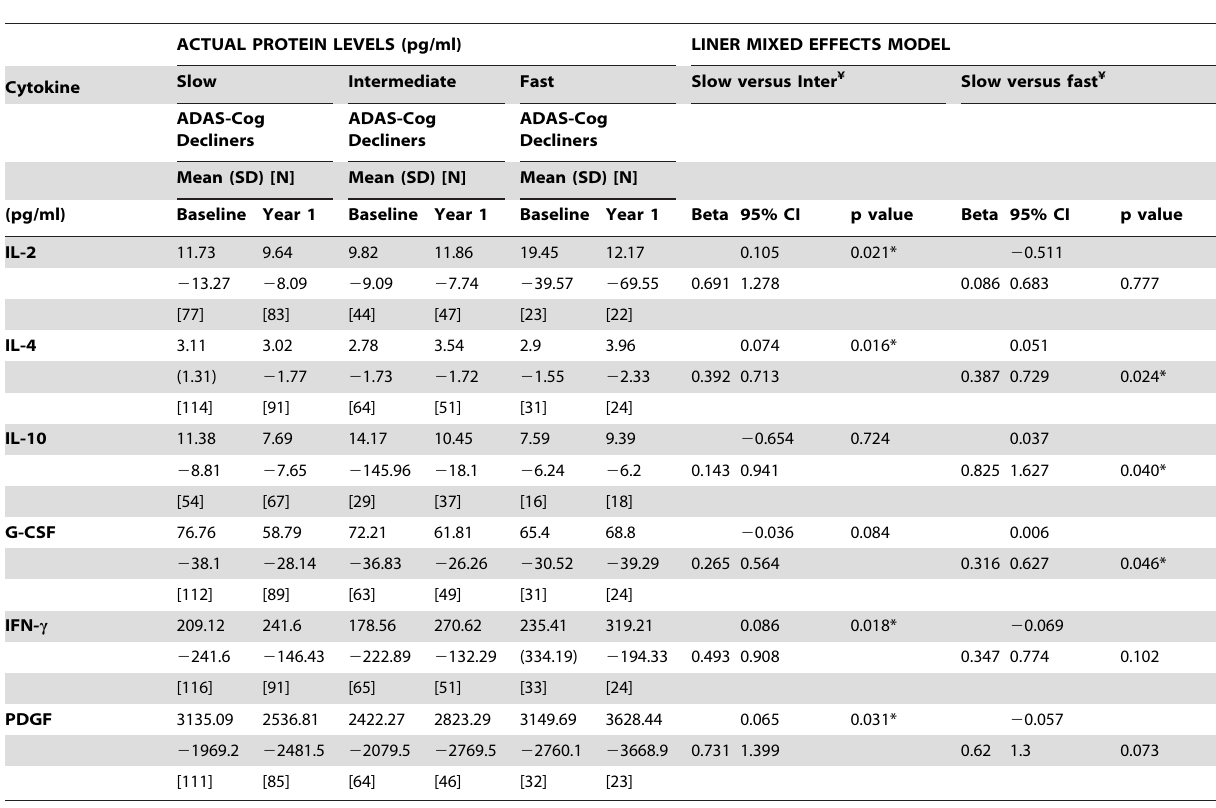
The relationship between change in cytokine levels over one year and AD cognitive decline group was assessed by mixed effect model adjusting for age, gender, APO e 4 allelle, collection site and disease duration. Slow indicates slow decliner. Inter indicates intermediate decliner. Fast indicates fast decliner. Key: Beta=regression coefficient (slope) on transformed data; 95%CI=95% confidence interval;N=number of sample; ¥ - coefficients represent the difference in the slopes for the given cytokine between cognitive decline groups across the two time points (i.e. interaction between time and the rate of decline groups). *p , 0.05.